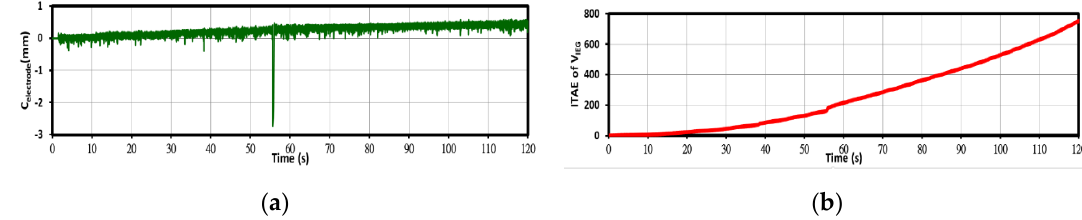
Figure 5. Analysis of process data: ( a ) the C electrode curve and ( b ) the integral of the time-weighted absolute error (ITAE) curve.